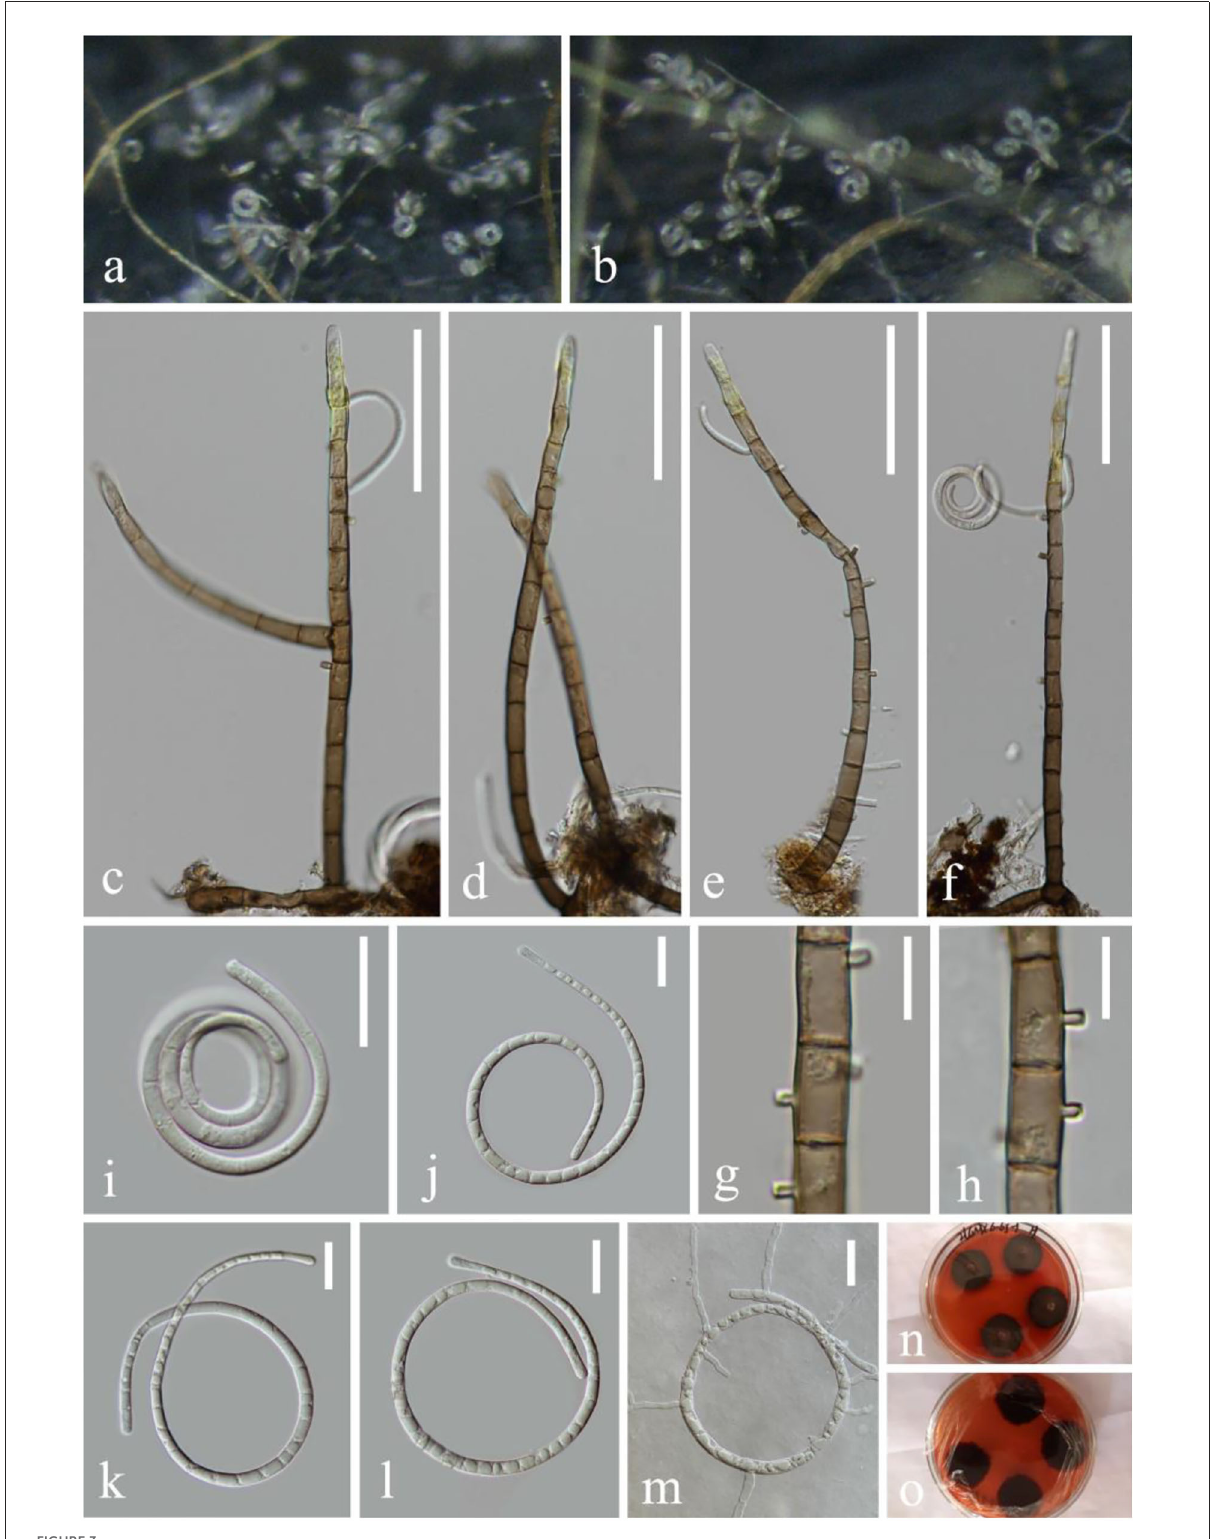
FIGURE3 Helicoma rufum (KUN-HKAS 124609). (a,b) Colony rises from mycelium on natural wood substrate. (c–f) Conidiophores with attached conidia. (g,h) Conidiogenous cells. (i–l) Conidia. (m) Germinating conidium. (n,o) Culture on PDA. Scale bars: (c–f) 60 µ m, (g,h) 10 µ m, and (i–m) 20 µ